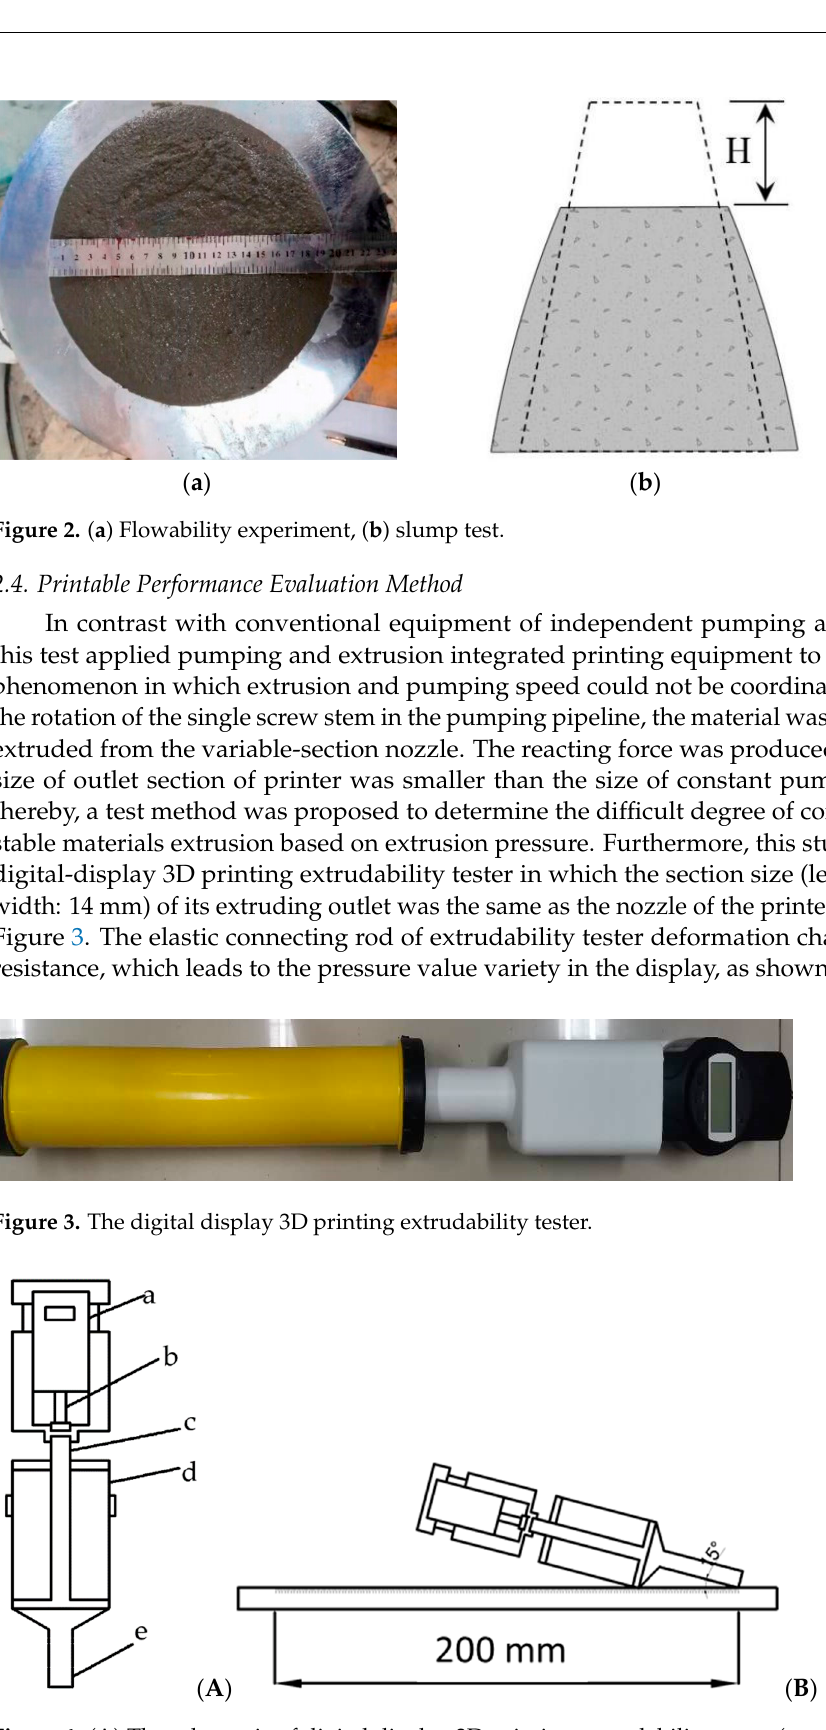
Figure 4. ( A ) The schematic of digital display 3D printing extrudability tester (a: sensor, b: elastic connecting rod, c: piston rod, d: piston barrel, e: rectangular extrusion nozzle) and ( B ) the test procedure of printable performance.